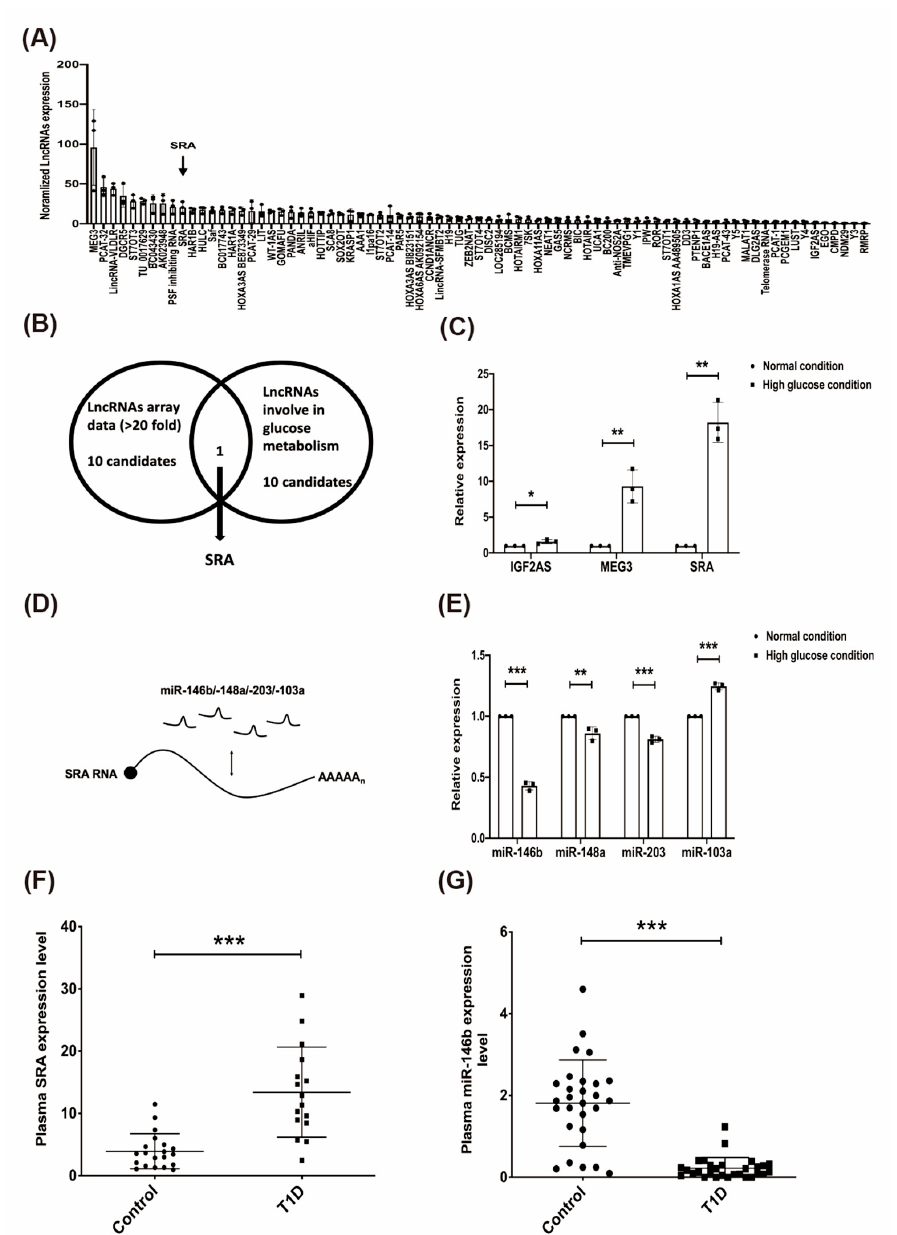
Figure 1. The effect of high glucose on candidate long non-coding RNAs (lncRNAs)/miRNAs in CD4+ MOLT4 Tregs and expression of lncRNA steroid receptor RNA activator (SRA)/miR-146b in the plasma of patients with type 1 diabetes mellitus (T1D). ( A ) Deregulated lncRNAs in high glucose (H) concentrations for 72 h (N: normalized to normal conditions). Each bar represents the expression of lncRNAs relative to that of the internal control. Cells were exposed to N/H conditions for 72 h. After treatment, RNA was isolated, and a disease-related lncRNA array was performed. ( B ) Venn diagram shows the high-glucose-induced lncRNAs (>two-fold, 15 lncRNAs, Table S1) in CD4+ MOLT4 Tregs and selected glycolysis-related lncRNAs from the literature (10 lncRNAs, Table S1). In total, ( C ) three lncRNAs (IGF2AS, MEG3, and SRA) and ( E ) four miRNAs (miR-146b, miR-148a, miR-203, and miR-103a) were assessed using real-time qPCR. * significant changes compared with the control ( p < 0.001). ( D ) Schematic representation of the competing endogenous RNA circuitry linking lncRNA-SRA and miR-146b/-148a/-203/-103a (Table S2). The plasma expression levels of ( F ) lncRNA SRA and ( G ) miR-146b in the control subjects and the patients with T1D. The plasma levels of lncRNA SRA and miR-146b were determined using real-time qPCR. Mean ± SD, Student’s t -test (unpaired, two-sided). * p < 0.05, ** p < 0.01, *** p <